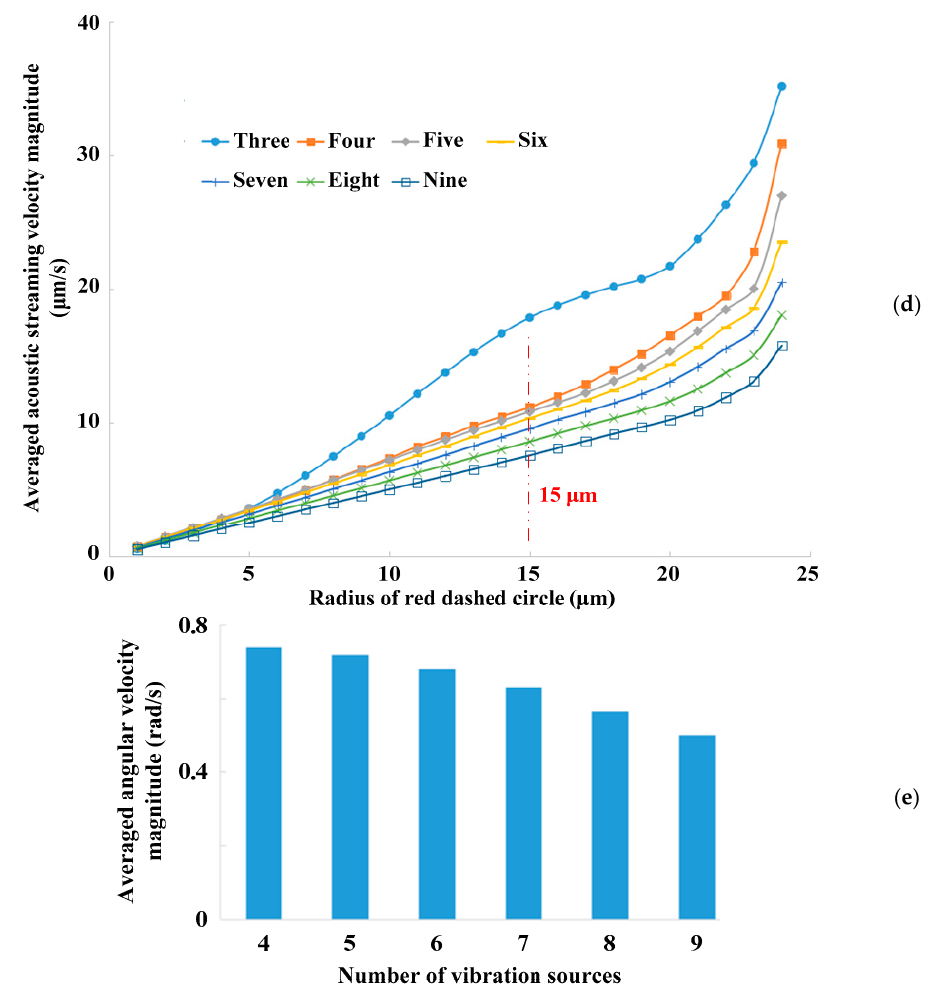
Figure 4. (Color online). Acoustofluidic field and particle trajectory excited by single-layer vibration sources with different initial phases. ( a ) Patterns of sound pressure field. ( b ) Patterns of acoustic streaming field. ( c ) Patterns of microparticle trajectory. ( d ) Averaged acoustic streaming velocity magnitude vs. radius of red dashed circle. ( e ) Averaged angular velocity magnitude vs. number of vibration sources.